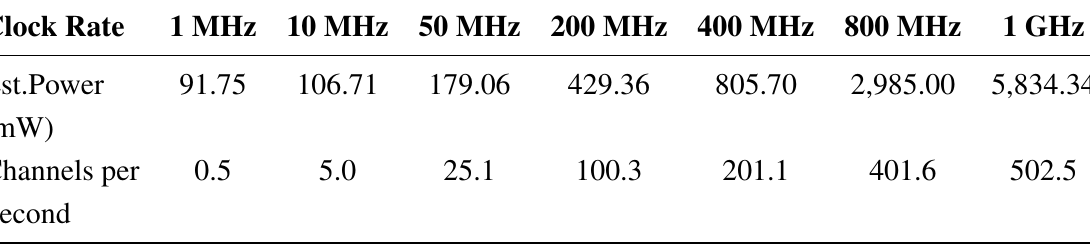
The estimated power consumption of the proposed GHA and FCM